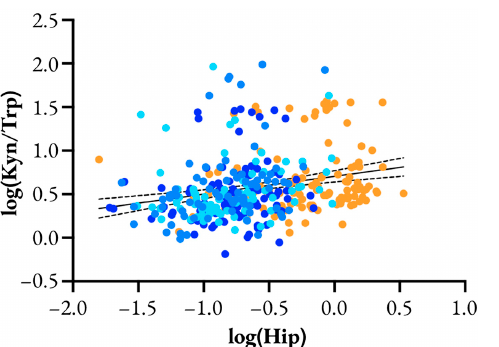
Figure 5. Log-log plot of urine hippurate (Hip) vs. kynurenic acid to tryptophan ratio (KynA/Trp). Different occupational groups are represented by color: •, cane harvest and seed cutters; •, other cane workers; •, Spain agricultural workers; •, non-agricultural workers. Solid line with dashed error represents the linear regression model with 95% confidence intervals.